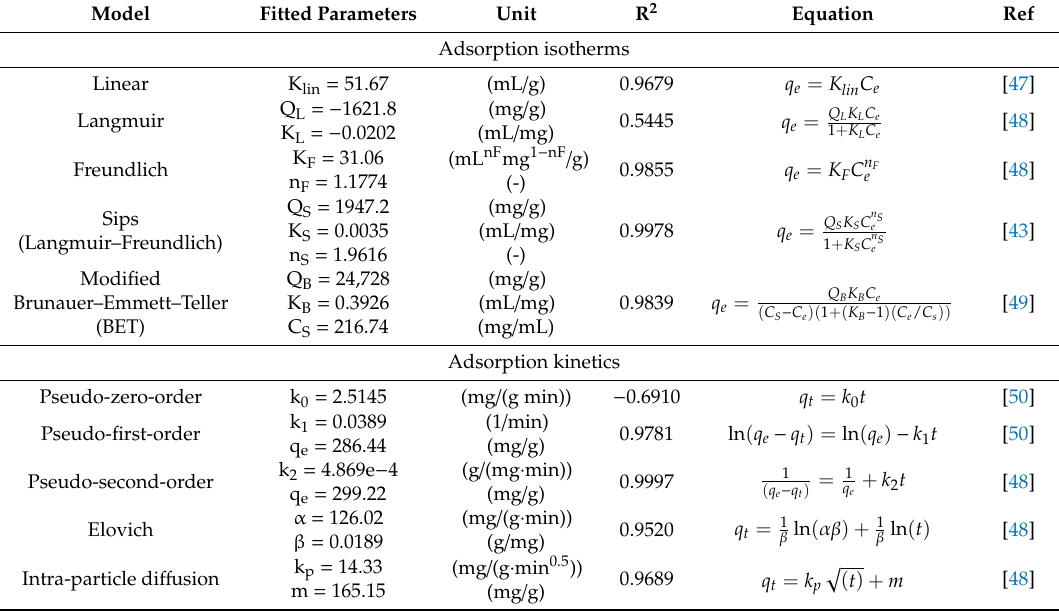
Table 2. Adsorption models for fitting the lignin adsorption data. The equilibration concentration ( C e ) was expressed in mg / mL, the adsorption capacity ( q e and q t ) was expressed in mg / g, and time ( t ) was expressed in